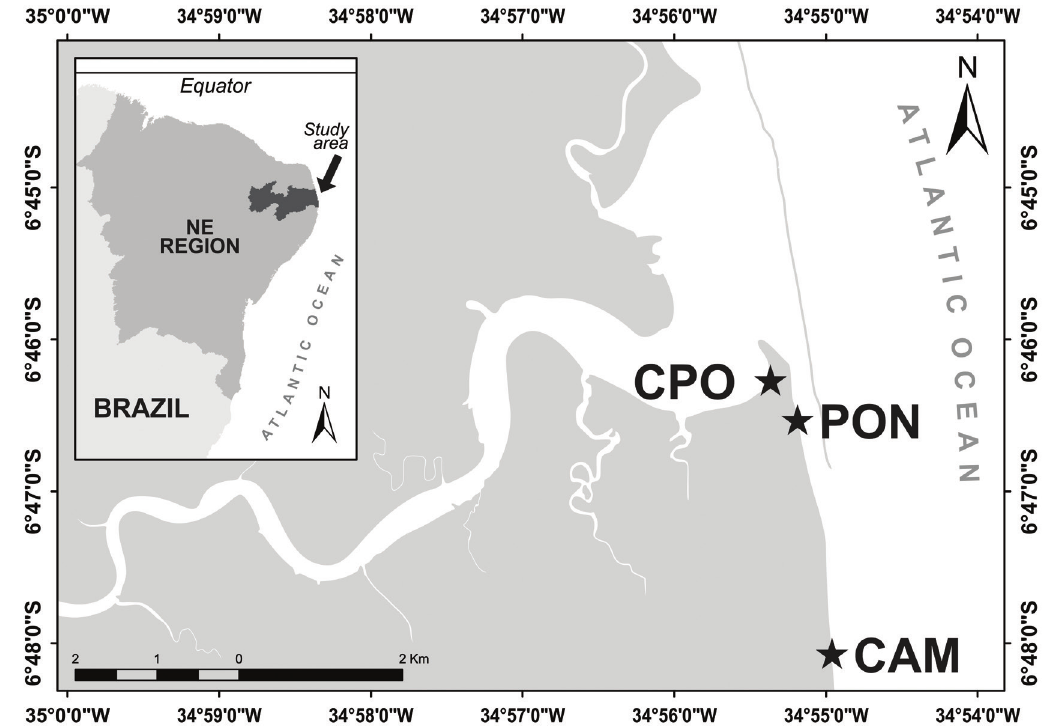
Fig. 1. Map of Mamanguape River estuary with locations of the sampling sites: CPO, Curva do Pontal Beach; PON, Pontal Beach; and CAM, Campina